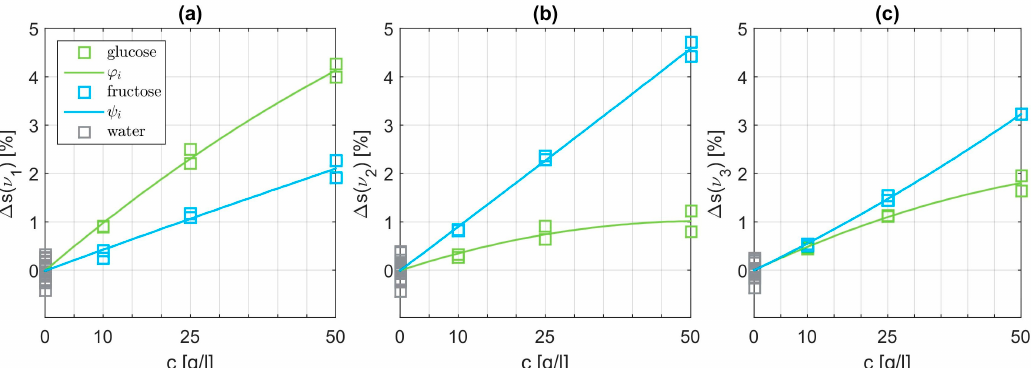
Figure 6. Signal peaks Δ𝑠 evaluated at the three characteristic wavenumbers 𝜈 (cid:2869) = 1034 cm (cid:2879)(cid:2869) ( a ), ν 2 = 1063 cm − 1 ( b ), and ν 3 = 1078 cm − 1 ( c ) originating from pure water for each of the three measurement cycles (gc = glucose cycle, fc = fructose cycle, and mc = mixed cycle).